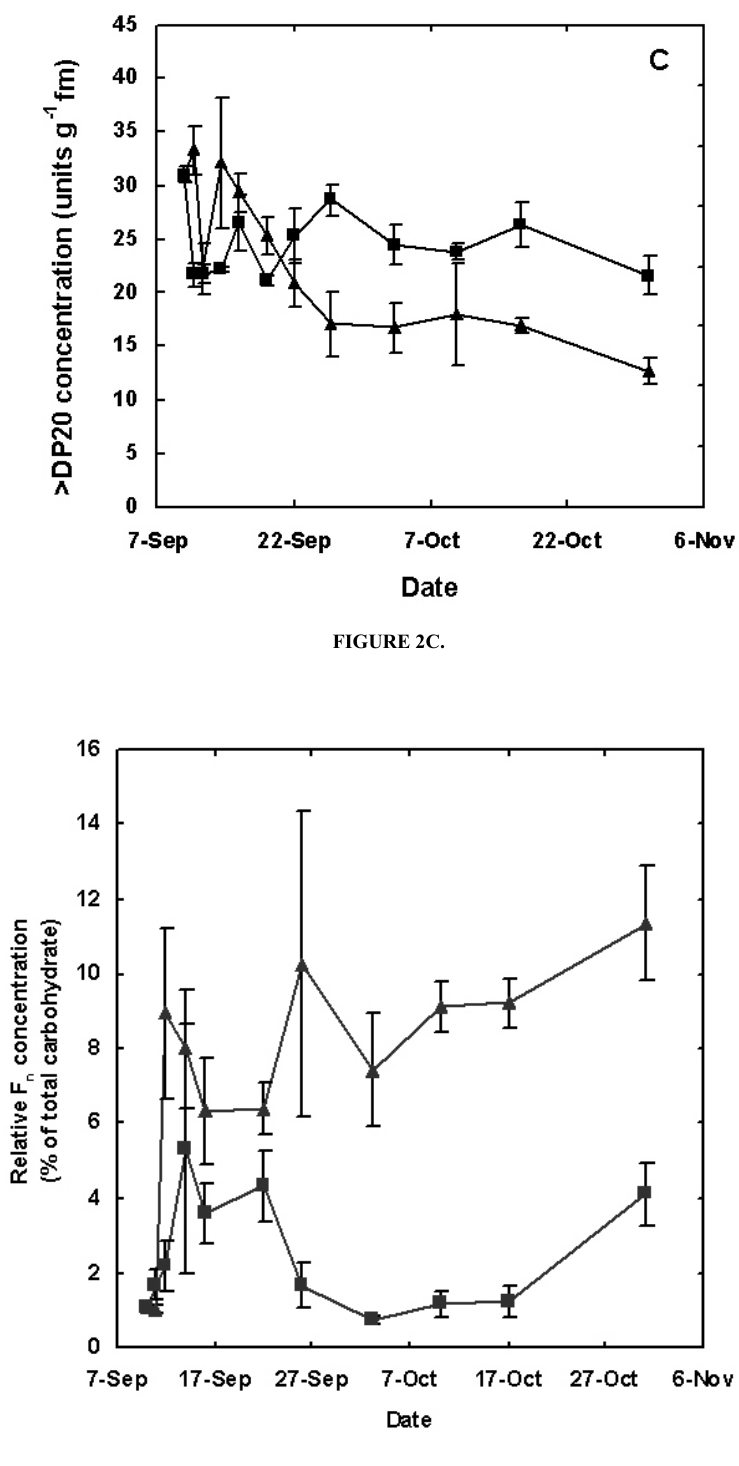
FIGURE 3 . Changes in the “relative concentration” of fructan lacking terminal Glc (F n series) in the roots of intact ( ■ ) and defoliated ( ▲ ) field-grown chicory